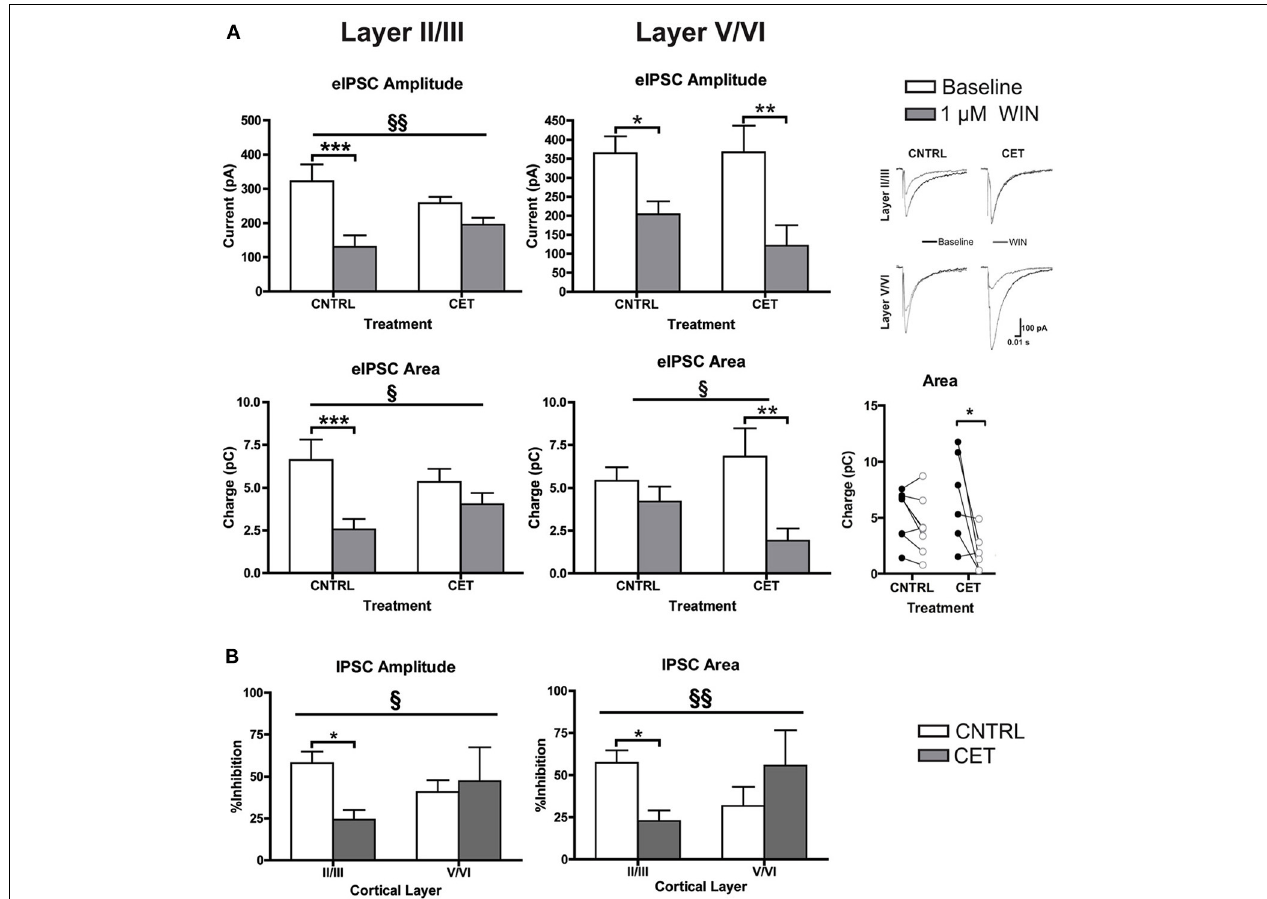
FIGURE 3 | CB1-mediated inhibition of GABAergic synapses on layer II/III PNs is blunted following CET. (A) The effect of WIN on evoked GABAA IPSCs recorded from layer II/III and layer V/VI PNs in control and CET cultures ( N = 6–13). White bars represent baseline measures and gray bars represent IPSCs recorded following a 10min application of WIN (1 μ M). The traces to the right are representative examples from each of the four groups. Traces in black are baseline, and the superimposed gray traces are from the same neurons in the presence of WIN. (B) The percent inhibition of IPSCs by WIN